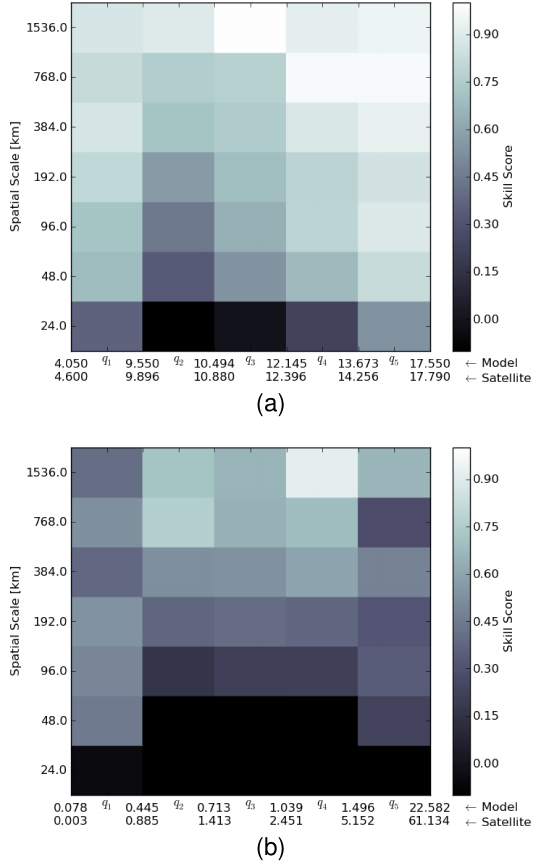
Fig. 2. Spatial scales versus quantile ranges plots for May 2004. Fig. 2 : Spatial scales versus quantile ranges plots for May 2004. Sea surface temper- Sea surface temperature (a) and chlorophyll- a concentration (b) ature (a) and chlorophyll- a concentration (b) skill scores. skill 20